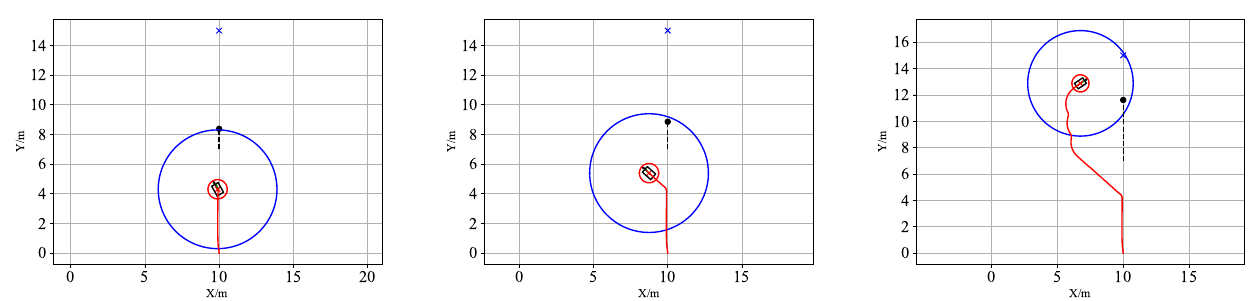
Figure 17. Parameters of the PSO-CCDWA algorithm for head-on situation. (2) Overtaking situation